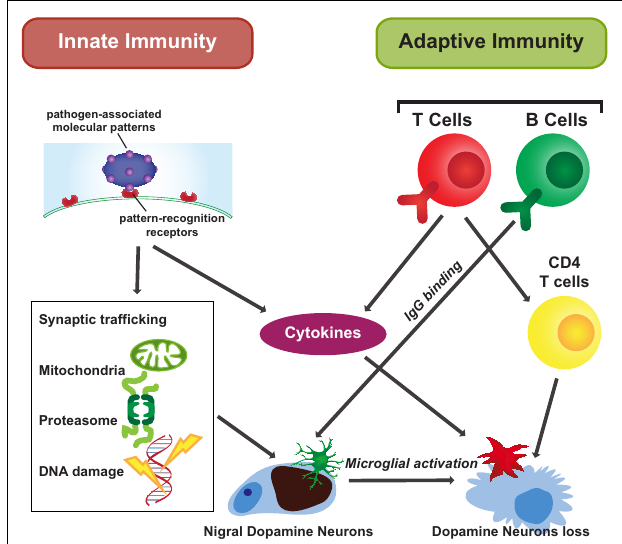
FIGURE 1 | Innate and adaptive immunity in PD. Innate and adaptive immunity are both thought to affect the cellular response to PD. Both produce cytokines facilitating microglial activation. Innate immune signaling is initiated by PAMP binding. Innate immunity influences cell functions through different organelles, such as the nucleus to affect DNA, the mitochondria and proteasome, and through impacting on synaptic trafficking. Adaptive immunity is a subsequent response. Antigen specific adaptive immune processes occur as immune cells survey the brain. In response to stimuli, B cells secrete IgG and CD4T cells are activated impacting on selective neuronal degeneration.